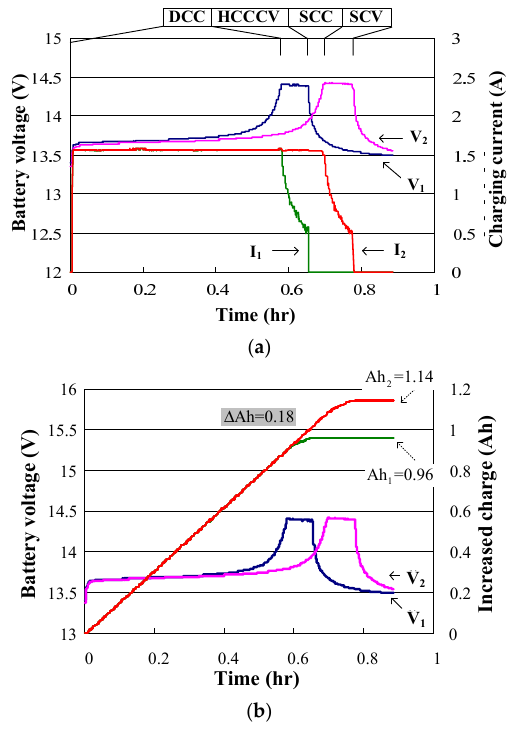
Figure 15. Measured data of charging two battery with large SoC difference. ( a ) the measured charging voltages and currents; ( b ) the increased charges of the two